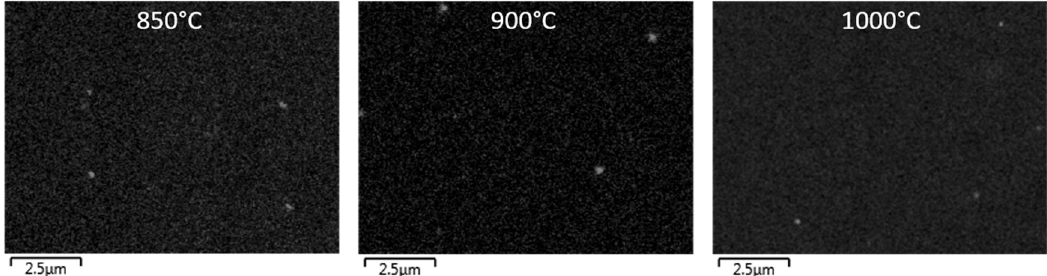
Figure 6. Typical images of niobium distribution in the microstructures produced by various soaking temperatures, obtained by EDS (Energy-dispersive X-ray spectroscopy) mapping. Light dots correspond to Nb enriched particles.